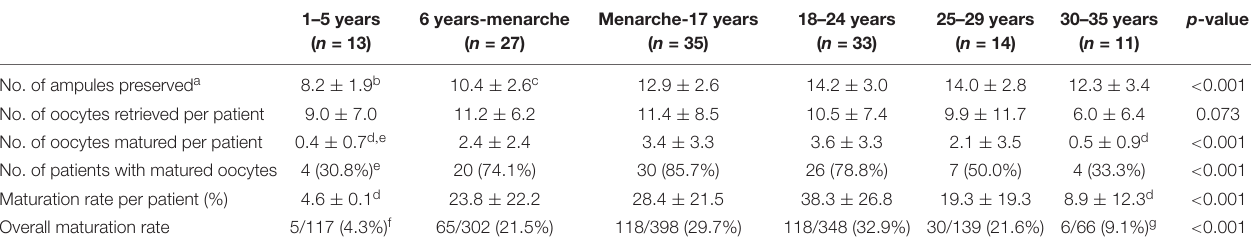
TABLE 2 | Comparison of ovarian tissue cryopreservation and in vitro maturation results according to age groups ( n =